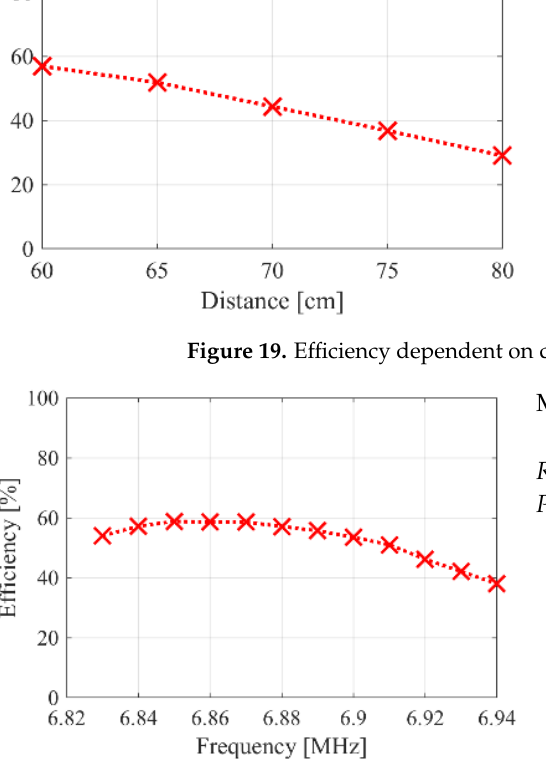
Figure 20. Efficiency dependence on frequency. Figure 19. Efficiency dependent on distance.